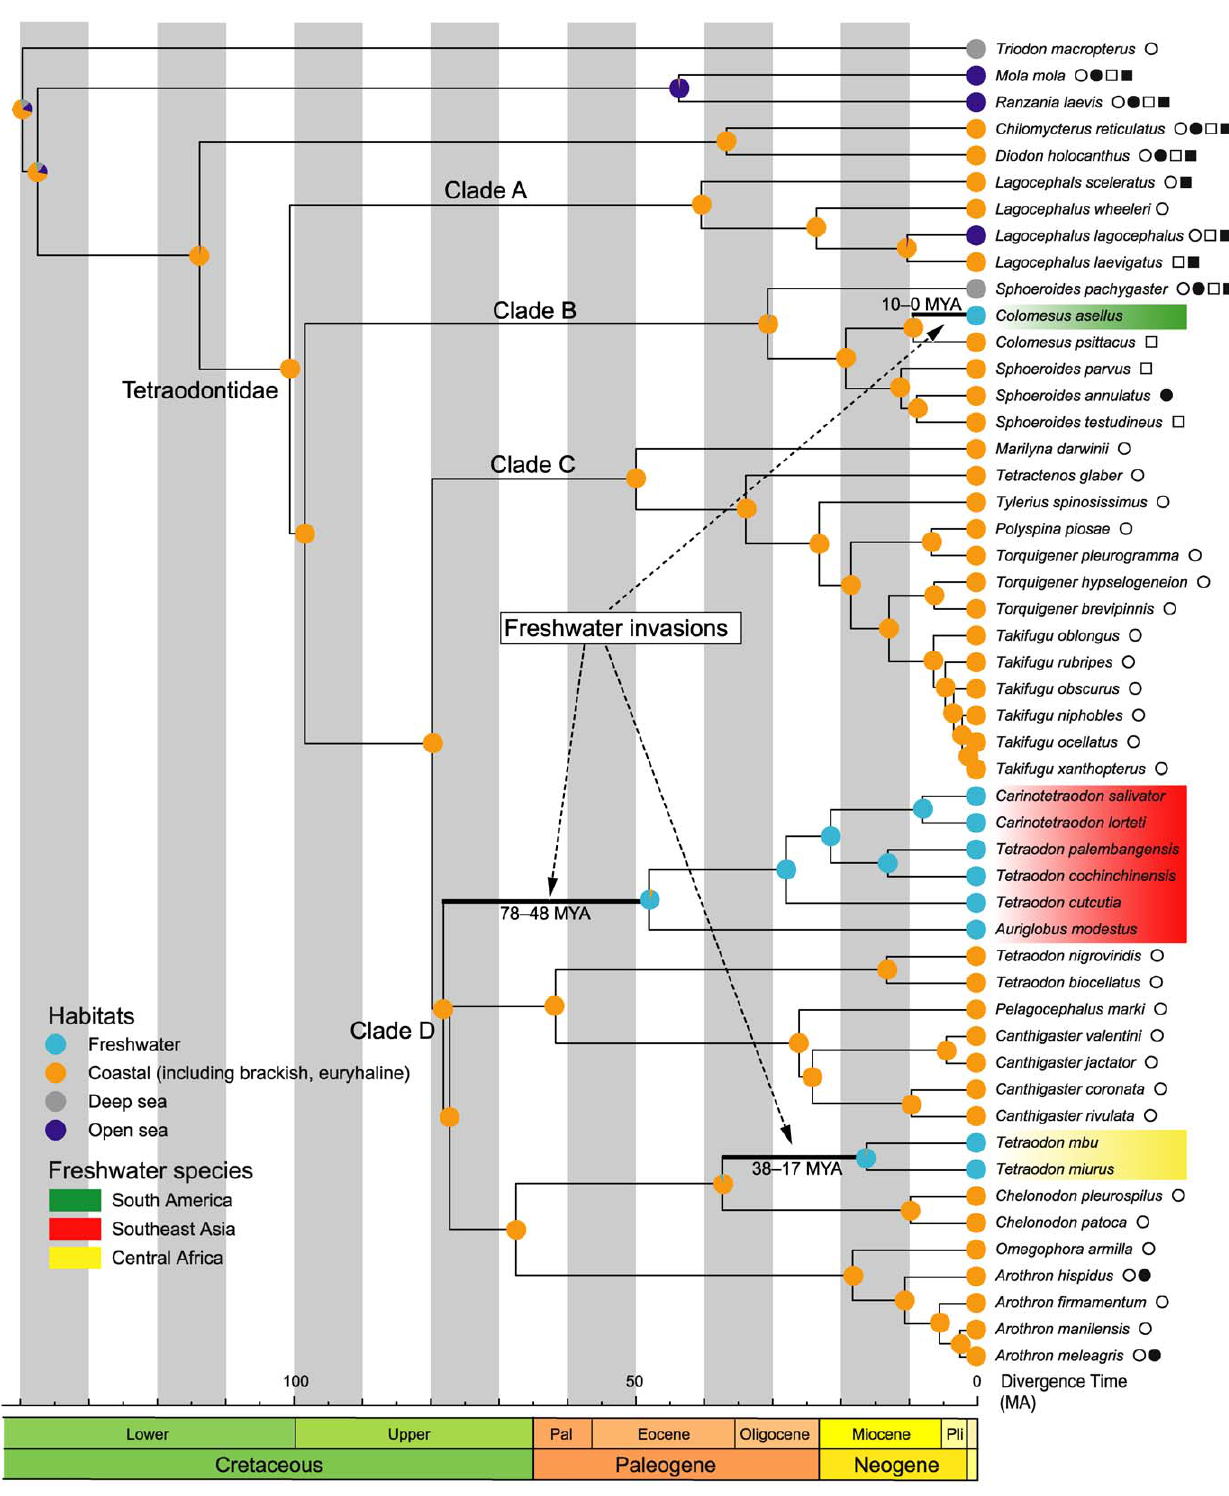
Figure 5. ML reconstruction of habitat types mapped onto the ML tree from the 12 n 3 r RT n dataset. Support for each character state is indicated in each node. Branches proposed for the occurrence of freshwater invasions are bolded and numbers besides the branches indicate estimated intervals for the invasion. Open and solid circles and open and solid squares indicate species distributions in the Indo-West Pacific (including Polynesian Pacific), East Pacific, West Atlantic, and East Atlantic (including Mediterranean), respectively.